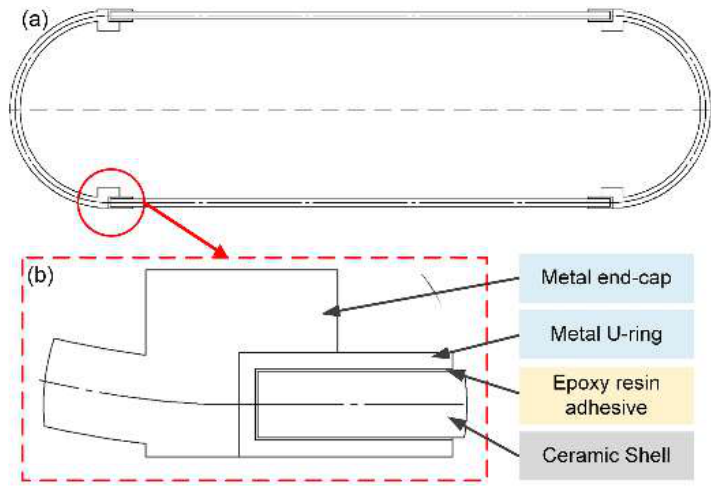
Figure 2. Geometry of a ceramic pressure housing. ( a ) Sectional view; ( b ) Partial